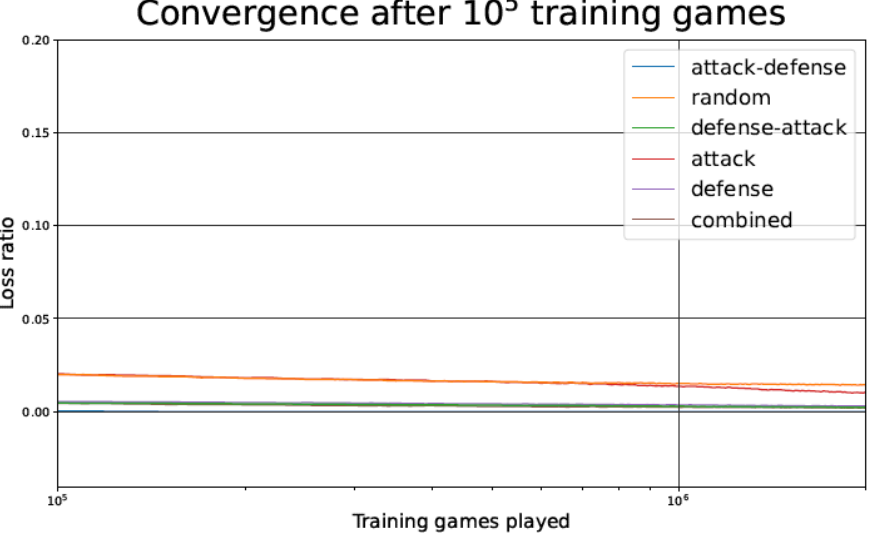
Figure 5. Tic-tac-toe TD agent loss ratio during the training phase as a function of the number of games played, for the different training strategies.